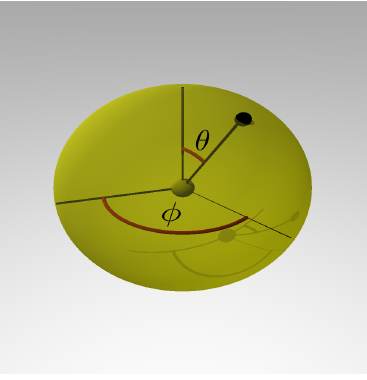
Figure 7. Specification of binding sites. Exemplary specification of a binding site with the angles, φ and θ , and the length of the bond, r . These variables correspond to spheric coordinates. Coarsely comparable to geographic coordinates, (90 ◦ − φ ) would correspond to the latitude, θ to the longitude and r would be the distance between the location and the Earth’s center. While φ gives the angle between the binding site and the vertical zenith axis, θ gives the rotation around this zenith axis.